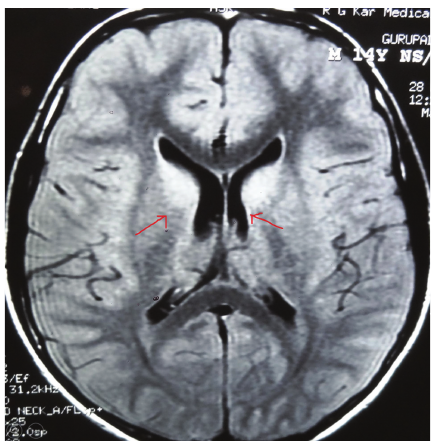
Figure1:MRI(T2FLAIR)showinghyperintensitiesofbothcaudate